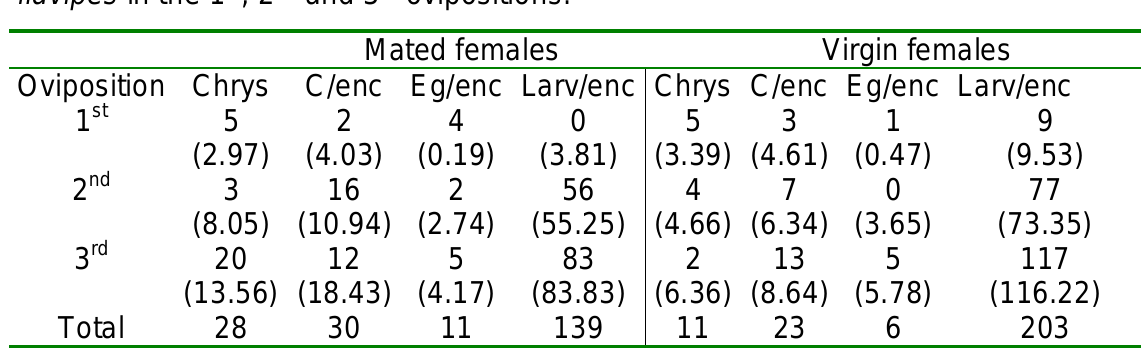
Table 3: D. saccharalis caterpillars parasitized by mated and virgin females of C. flavipes in the 1 st , 2 nd and 3 rd ovipositions.